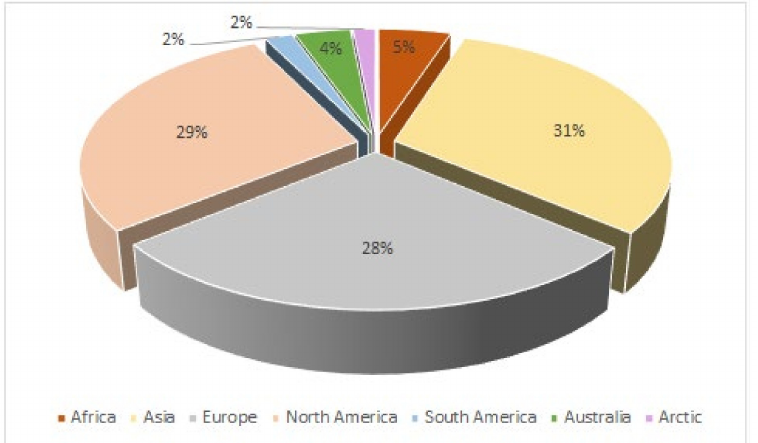
Figure 7. Percentage of research carried out on the continents. The sum does not coincide with the number of the analyzed publications, as studies performed on the global and hemisphere scale are not included in the analysis.